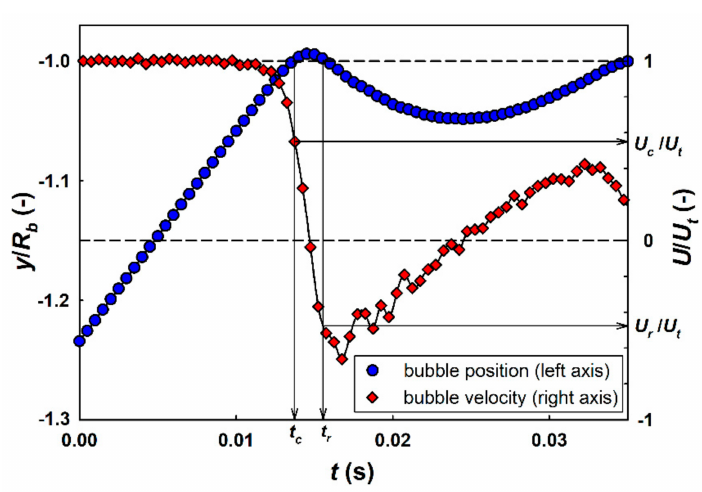
Figure 3. Time dependence of normalized bubble position (left y-axis) and velocity (right y-axis). Explanation of impact and rebound moment evaluation. Deionized water, D b = 1.05